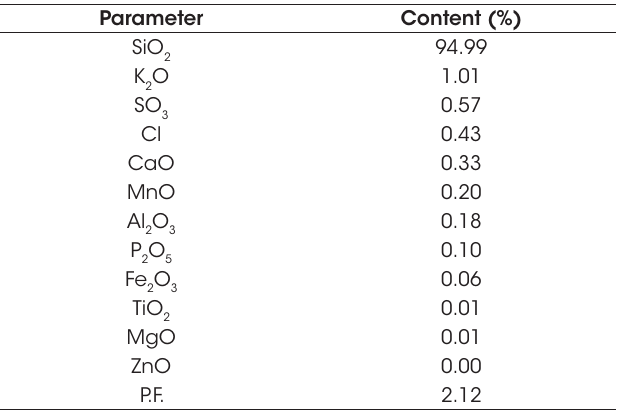
Normal amount of water (%)